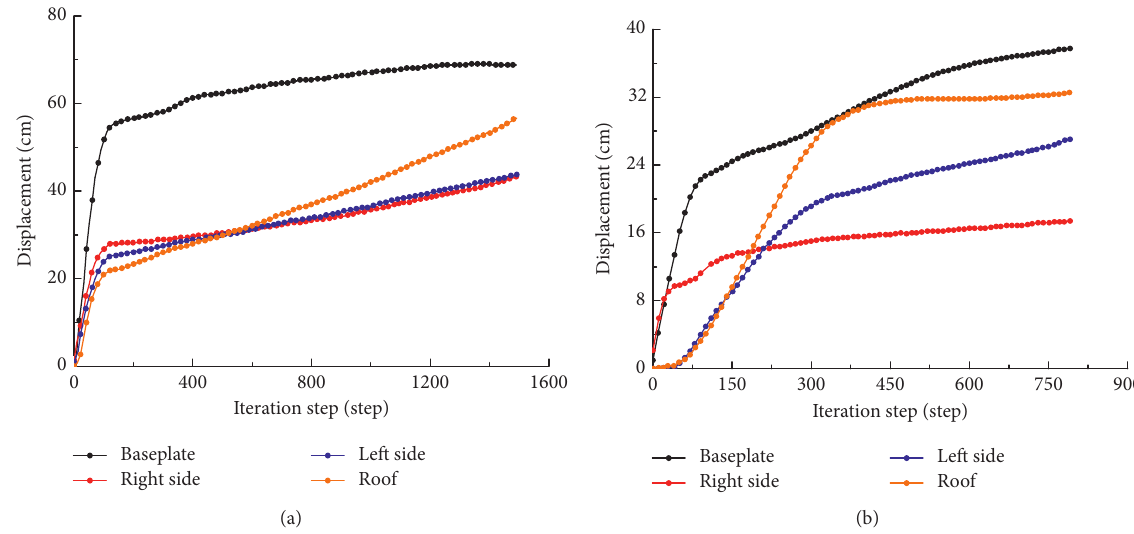
Figure 9: Displacement curve distribution of rubber-tire haulage gateway 14203 in two schemes. (a) Nonhydraulic fracturing. (b) Hydraulic fracturing.